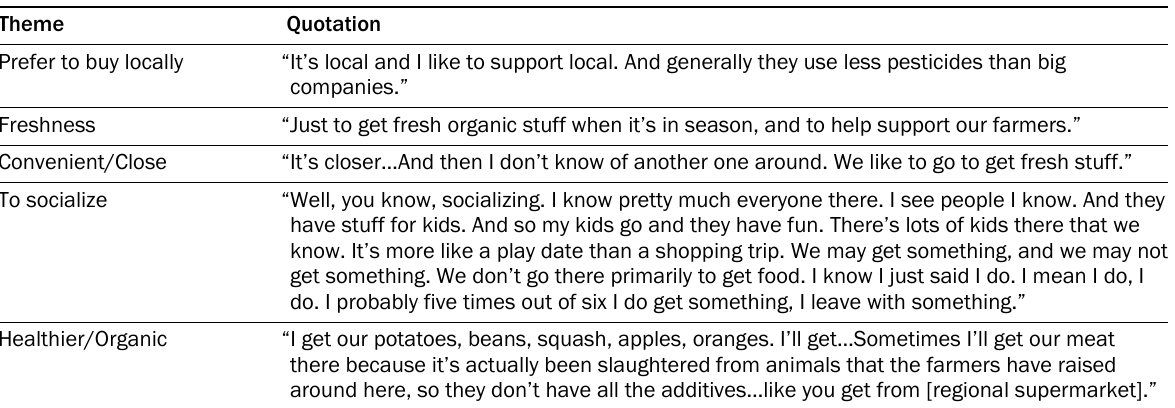
Table 4. WNC Reasons for Procuring Food from Local Food Sources